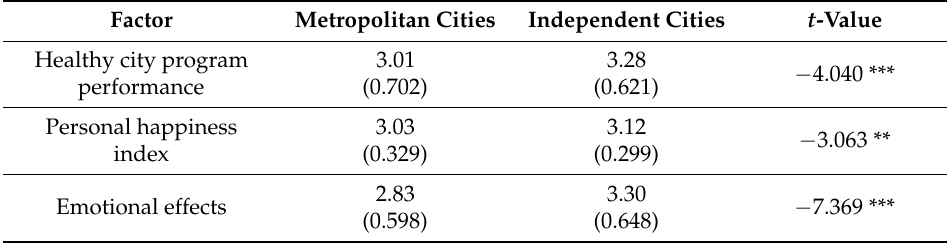
Table 5. Analysis of average differences between metropolitan cities and independent cities.